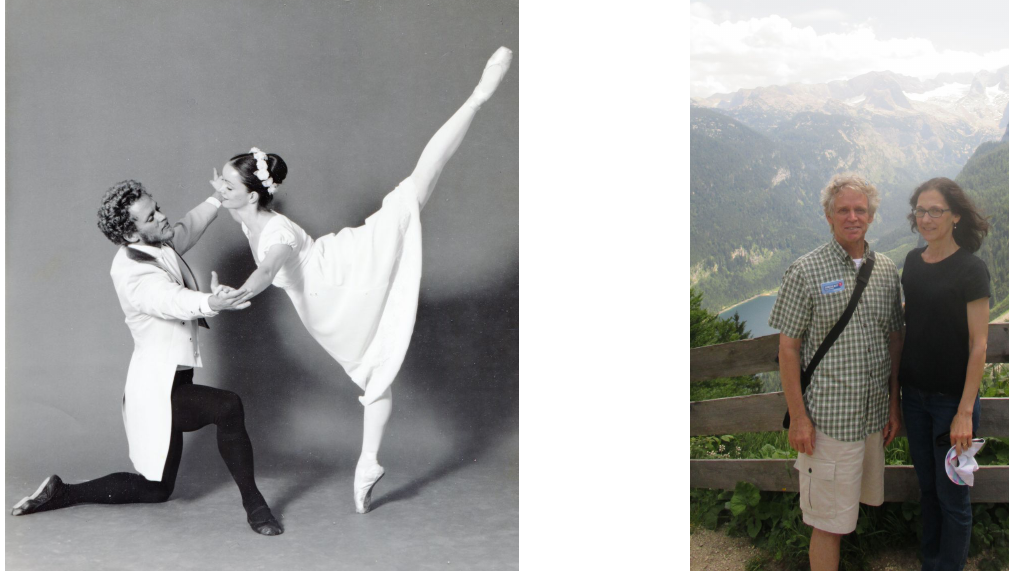
Figure 8: The left-hand photo shows Jed with M’Liss (Gary) Dorrance from a ballet performance while he was a doctoral stu- dent in 1982. The right-hand photo is Jed and Deirdre in the Austrian Alps after the 2017 Insurance Mathematics Conference in